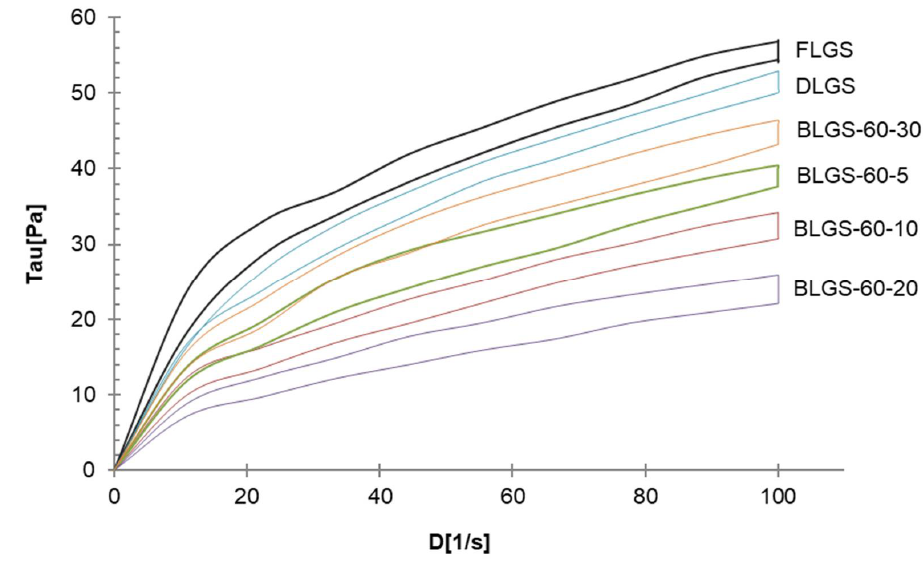
Figure 3. Representative rheological profiles of longan seed starches of varied materials.